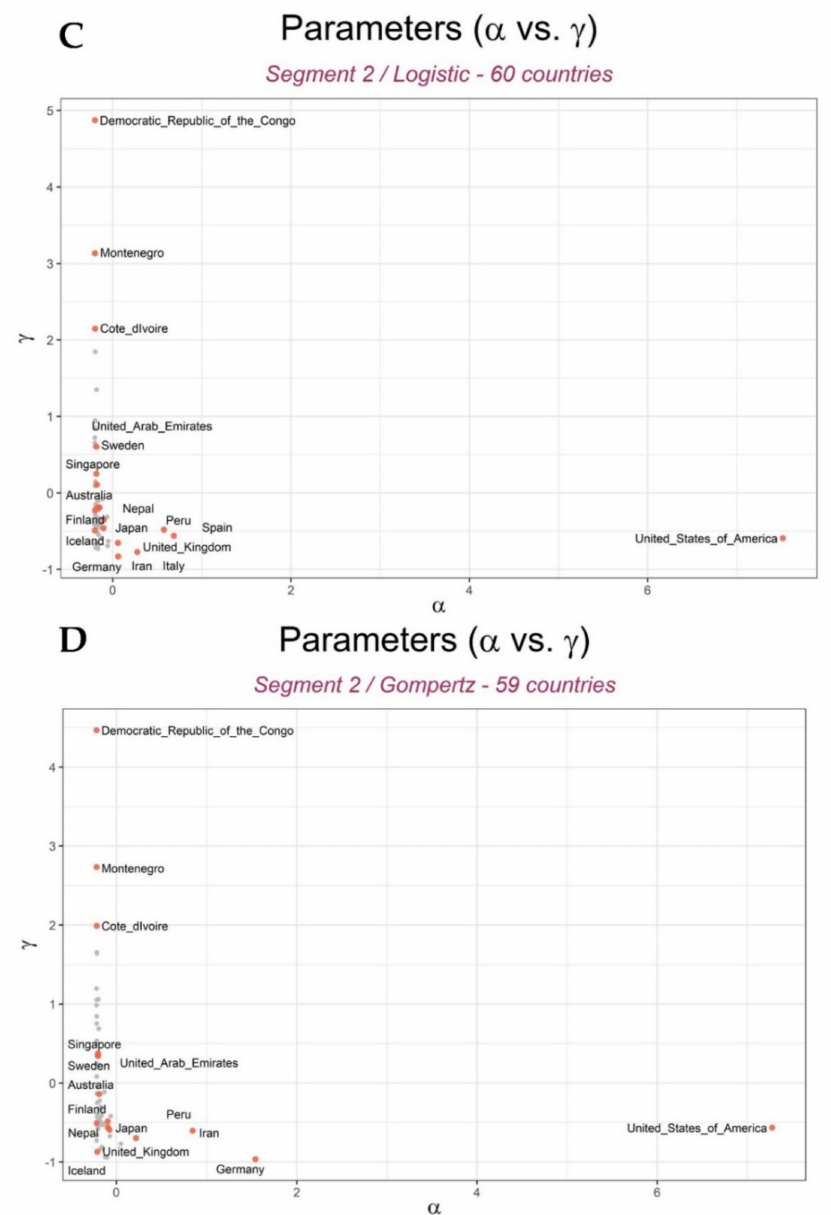
Figure 4. Differences in values of maximum predicted cumulative cases ( α ) and rate of spread of COVID-19 observed ( γ ) among countries. ( A , C ) The variation of α vs. γ using the logistic model for the first and second segments, respectively. ( B , D ) The variation of α vs. γ using the Gompertz model for the first and second segments,